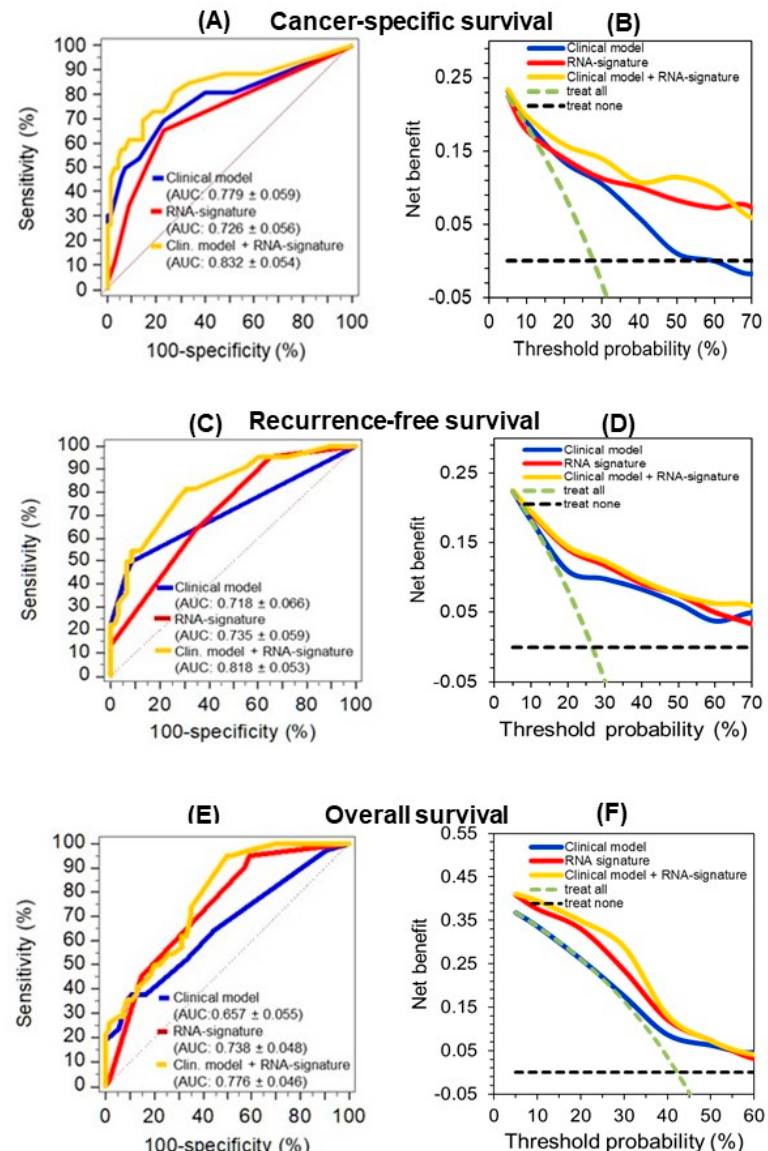
Figure 6. Improved predictive accuracy of cancer-specific (CSS), recurrence-free (RFS), and overall survival (OS) in a model with clinicopathological variables by including a circular RNA (circRNA) based signature. ( A , C , and E ) C-statistics curves of the prognostic indices of Cox regression analysis for the three endpoints using the models indicated in Table 5 (“clinical model”, “RNA signature”, and the combination of both (“clinical model + RNA signature”) as well as ( B , D , and F ) the corresponding curves of decision curve analysis are shown here. The AUC values were not significantly different between the clinical model and the RNA signature for CSS ( p = 0.452), RFS ( p = 0.837), and OS ( p = 0.268). The improved predictive accuracy of combining the “RNA signature” with the pure “clinical model” is shown by the increased AUC values indicated in parentheses next to the models in the subfigures. Curves in the decision curve analysis confirmed the benefit of combining the RNA signatures with the “clinical